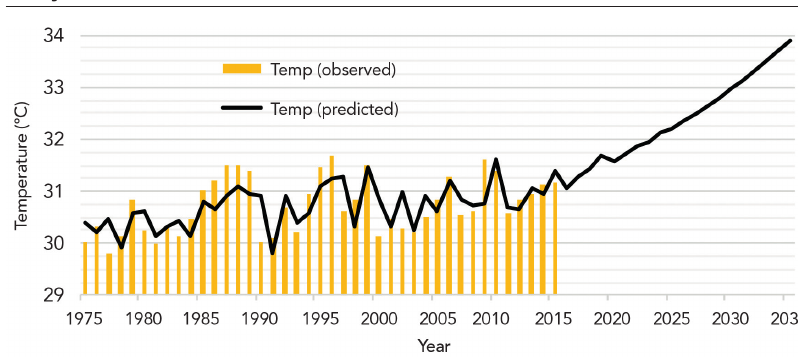
Figure 6: Observed and predicted temperature (using MA (1 10) model) of the study